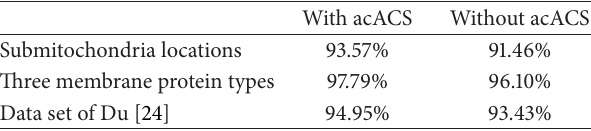
Table 1: The comparison of the results with and without the acACS for predicting submitochondria locations and three membrane protein types with comparison to that without acACS.